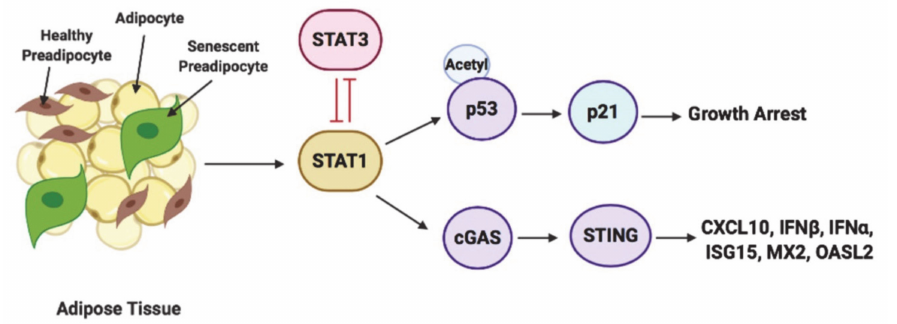
Figure 9. Model of STAT1 and STAT3 regulation of inflammation and growth arrest phenotypes in senescent preadipocytes. This schematic diagram represents how STAT1 and STAT3 function antagonistically in regulating cGAS-STING mediated induction of CXCL10 and interferon signaling related genes and p53/p21-dependent growth arrest. STAT1 cooperates with cGAS/STING in driving the induction of CXCL10, and interferon signaling related genes such as IFN α , IFN β , ISG15, MX and OASL2 and antagonizes the function of STAT3 in inhibiting p53-dependent growth arrest and cGAS-dependent induction of interferon signaling related genes.